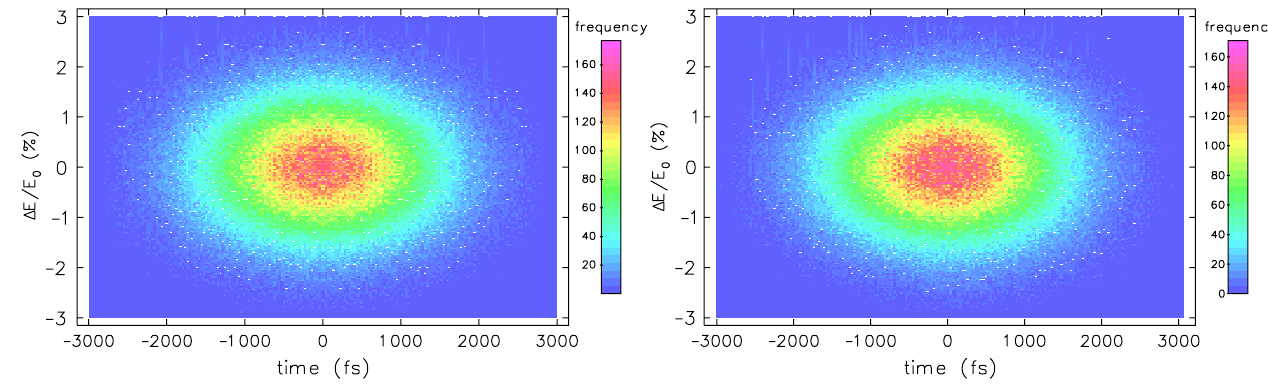
beam.FIG. 10. Longitudinal phase space of the beam. Left: Initial phase space before injected into the bypass. Right: At the end of the bypass beam line.